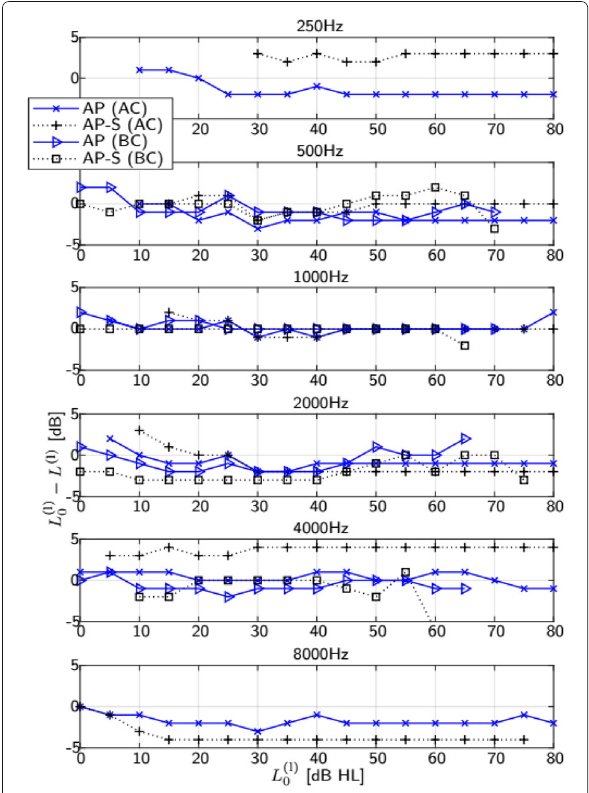
Fig. 4 Accuracy for AC and BC testing (ε FA = ε MD = 0 )